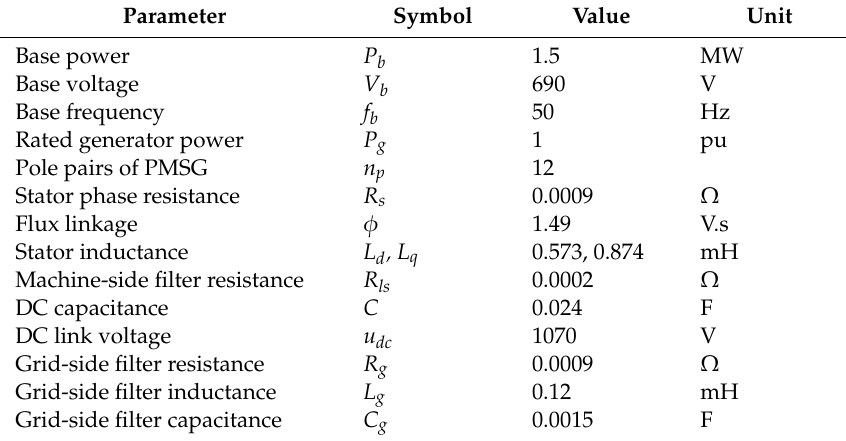
Table A1. Main parameters of the wind energy conversion